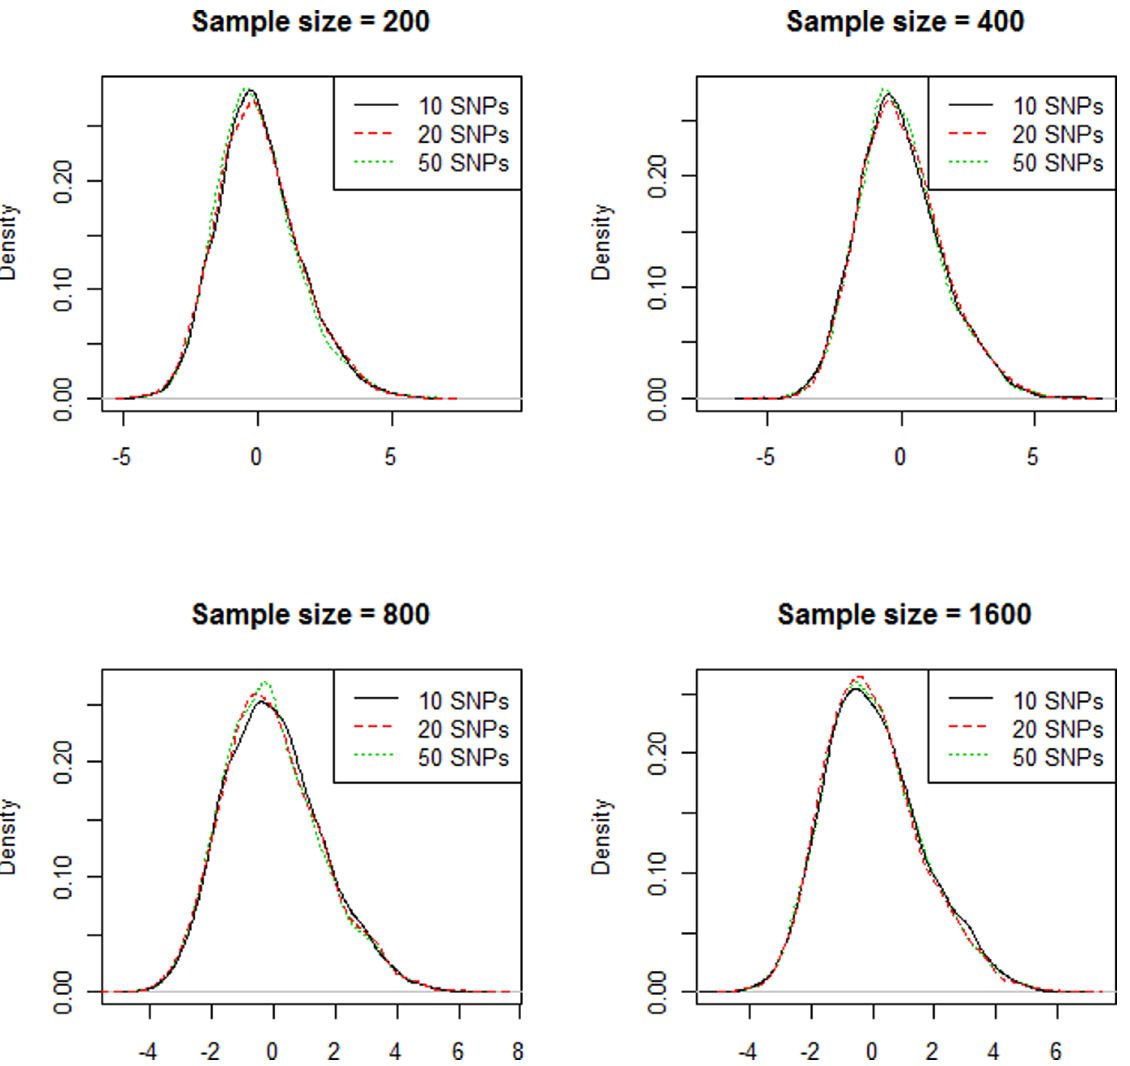
Figure 2. Empirical distribution of the 10-fold cross-validated testing score. The three curves on each figure represent testing scores from datasets with 10, 20, and 50 SNPs.